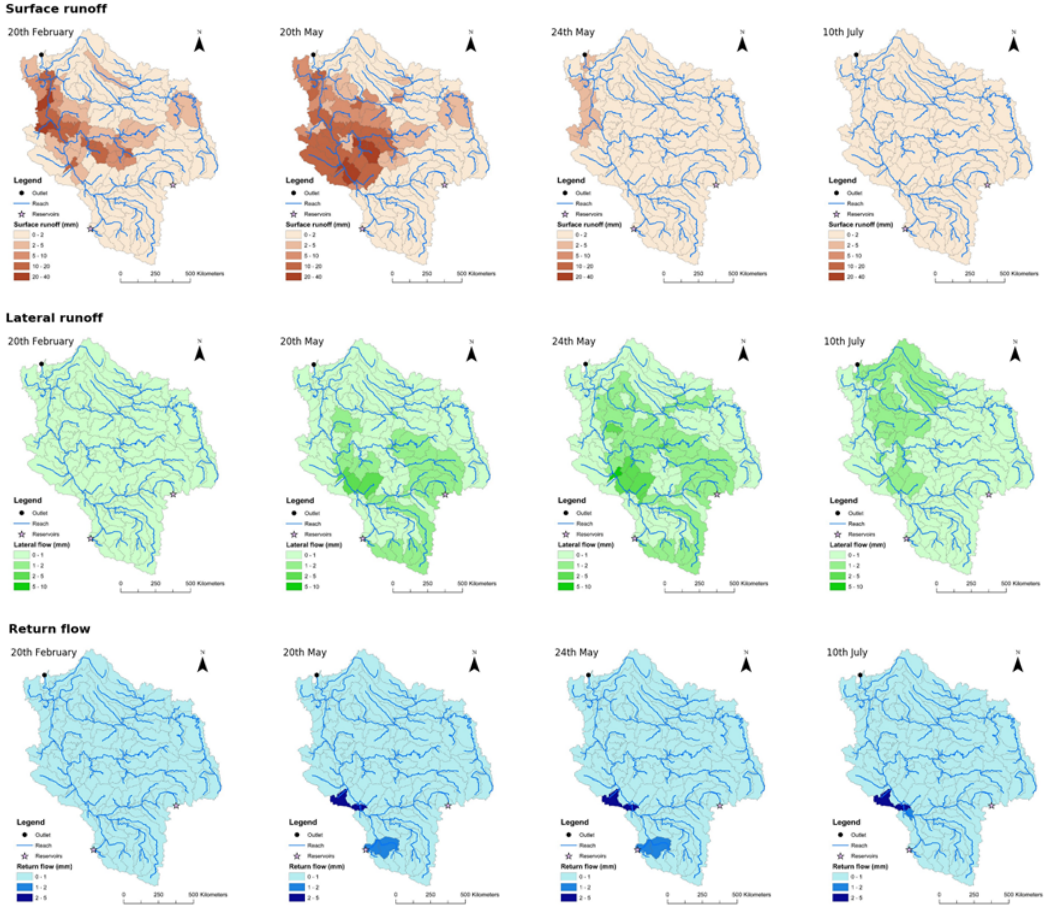
Figure 4. Spatial water flows dynamics at different key periods of the year 2013 in the Yenisei watershed (frozen period, unfreezing, peak of discharge and recession; see Figure 5). The strong disturbance in the surface and lateral runoffs during snowmelt and permafrost unfreezing is clear.